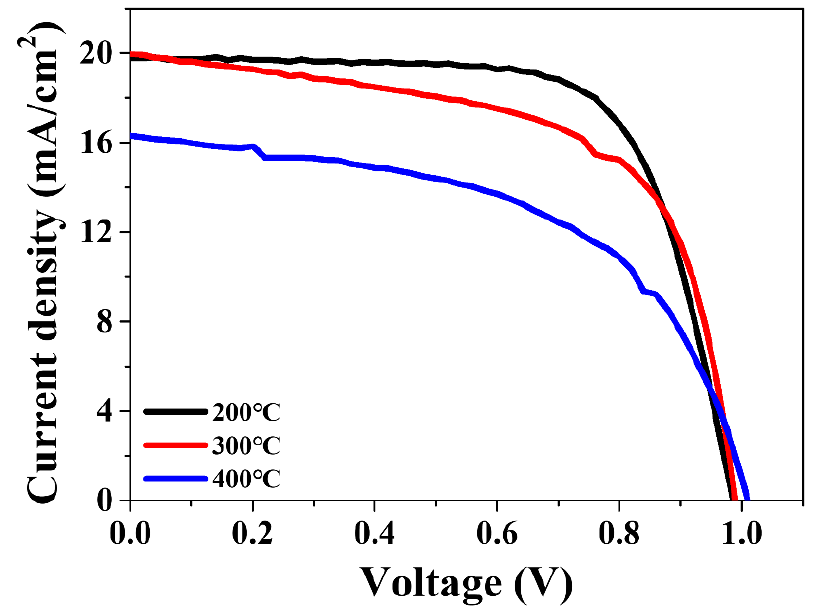
Figure 2. Reverse scan current density–voltage (J-V) curves of perovskite solar cells based on SnO 2 ETL annealed at 200, 300, and 400 °C.